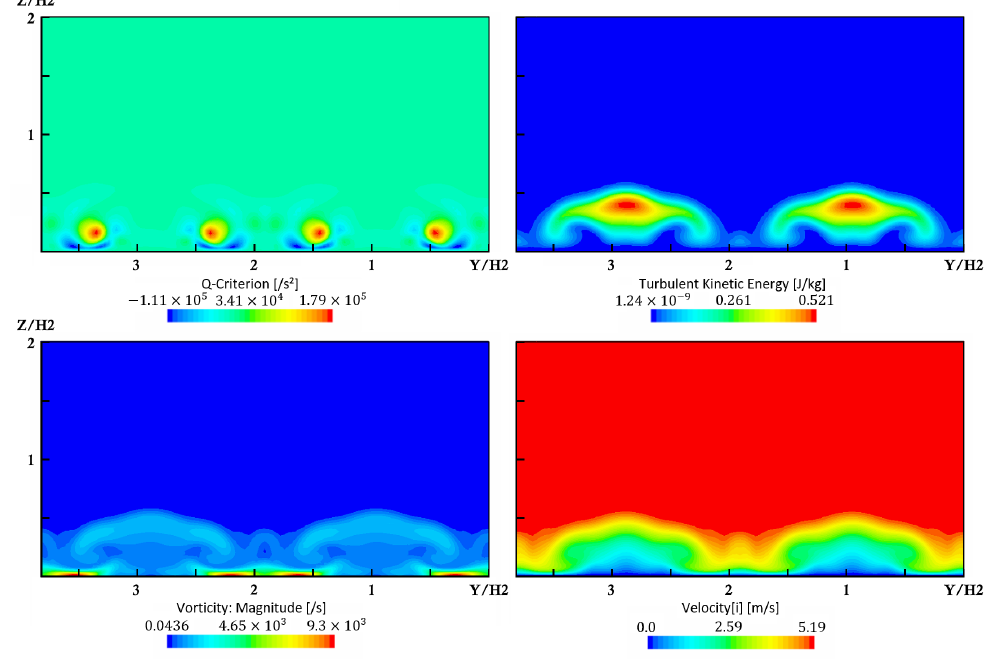
Figure 19. Comparison of simulated Q-criterion, turbulent kinetic energy, vorticity and axial velocity on a cross-section in the wake of the knitted wire mesh at X/H 2 = 13.17.